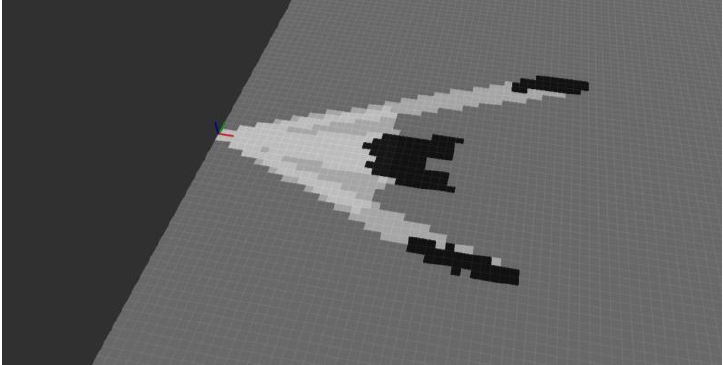
Figure 16. Occupancy grid computed from both the ultrasound and the depth camera measurements.